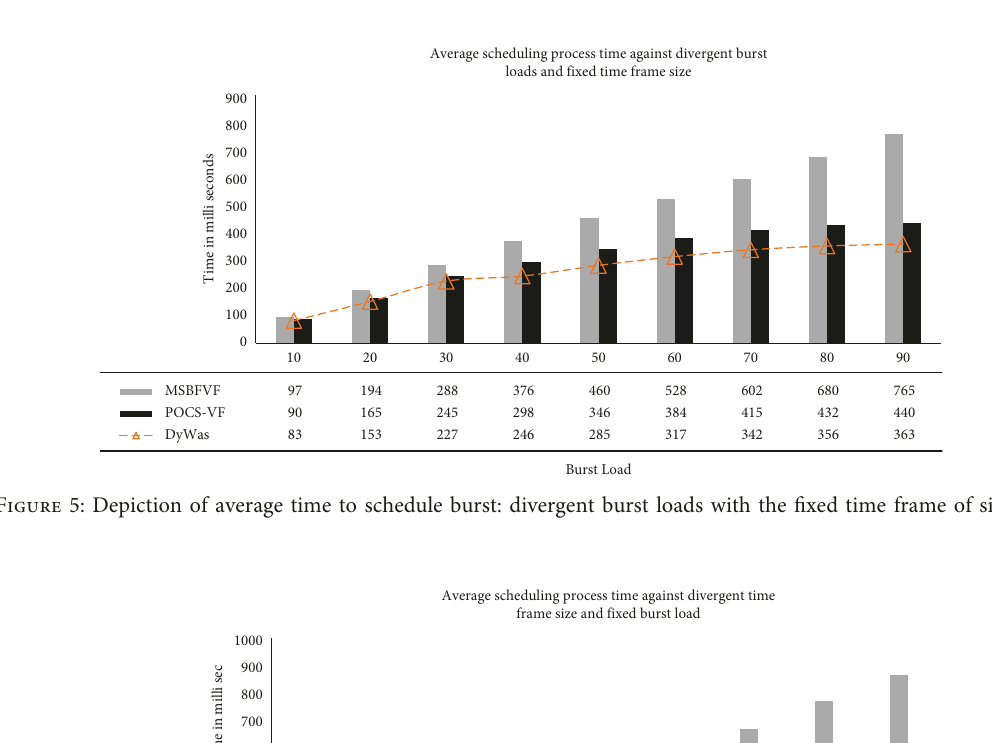
Figure 4: A depiction of how many bytes each channel uses under a wide range of timeframes and a burst load of 35680 bytes.